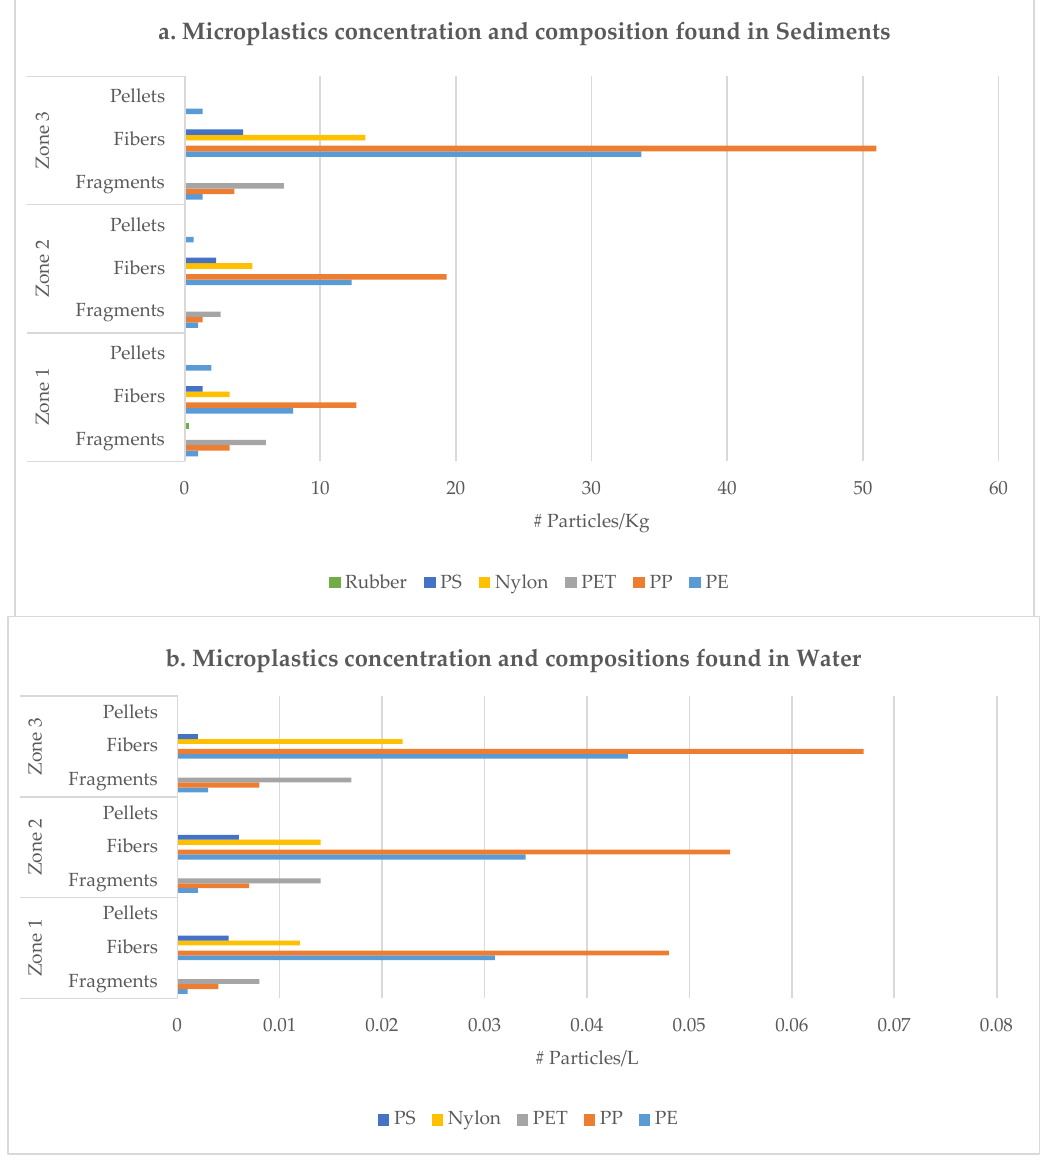
Figure 3. Microplastic concentrations and compositions found in shoreline sediments and surface water for each site. Polystyrene (PS), polyethylene terephthalate (PET), polypropylene (PP), polyethylene (PE). Graphic a shows the results for sediments, graphic b shows the results for water.